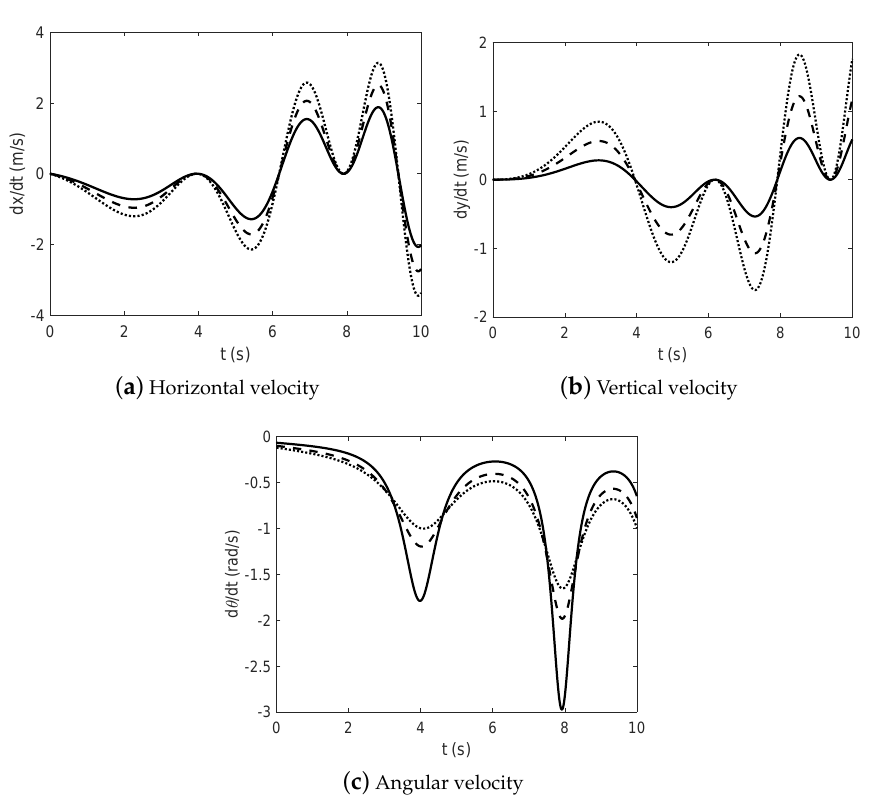
Figure 4. Robot velocity. Initial conditions 1 (solid lines), initial conditions 2 (dashed lines), initial conditions 3 (dotted